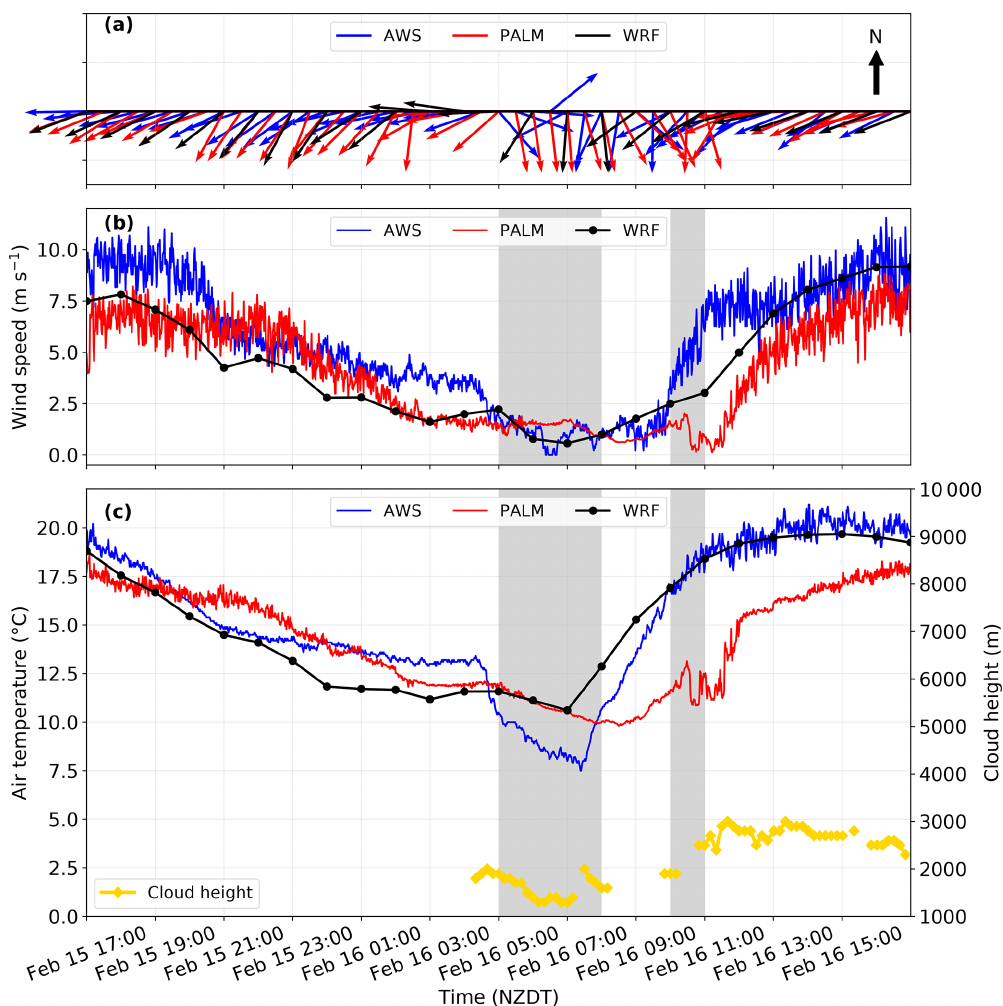
Figure 10. As in Fig. 4, but for the north-easterly case between 17:00NZDT, 15 May 2017 and 17:00NZDT, 16 May 2017.